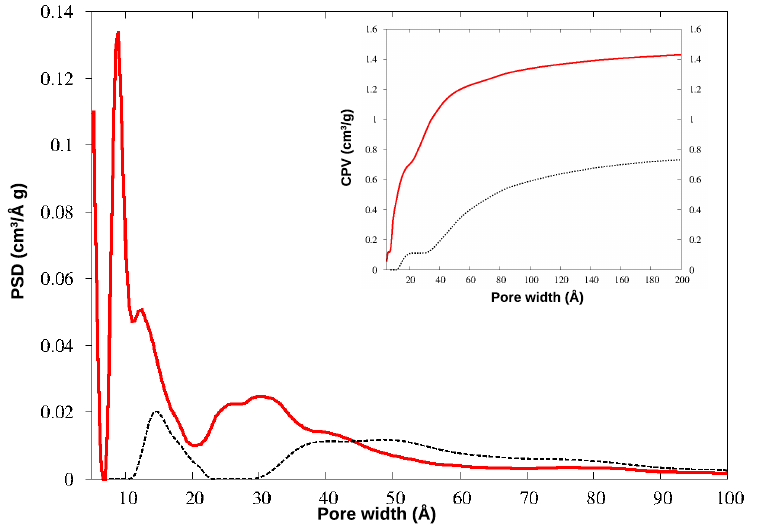
Figure 5. Pore size distribution (PSD) and cumulative pore volume (CPV, insert) for HCP-PS (black dotted line) and KPS-1 (red solid line) from N 2 adsorption at 77